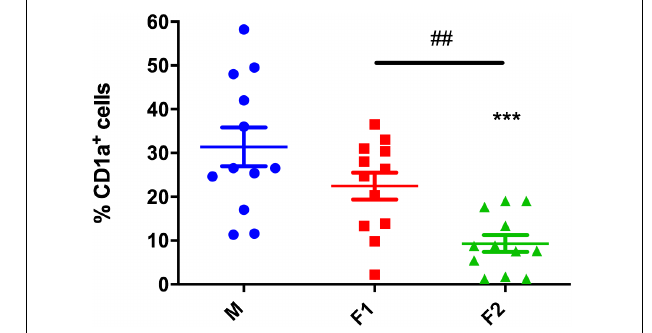
FIGURE 2 | Paracoccidioides brasiliensis α -glucan-rich cell wall fraction modulates differentiation of CD1a + dendritic cells. Cell frequency of CD1a+ cells after differentiation upon F1 or F2 stimulation. Non-stimulated cells were used as a control (M). Each data point represents one donor. Wilcoxon matched pairs T test. ∗∗∗ p < 0.01 in comparison to control group. ## p < 0.01 between groups treated with cell wall